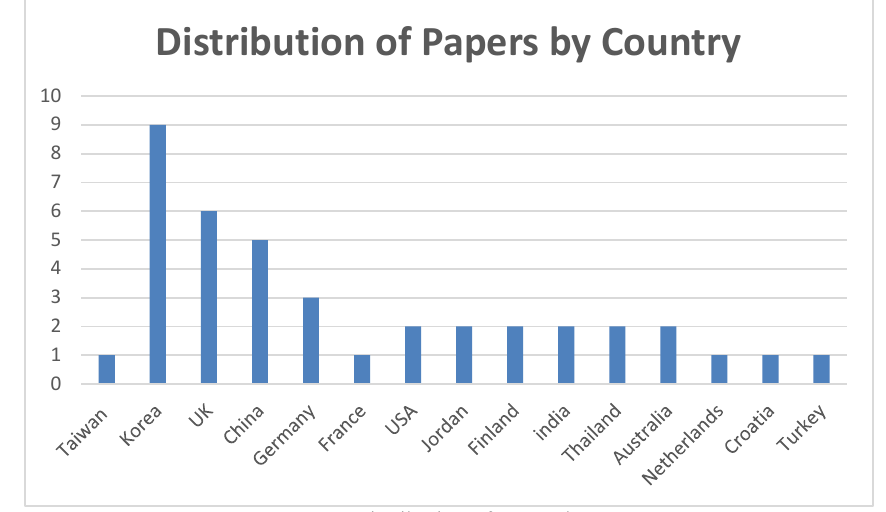
Fig. 4. Distribution of papers by